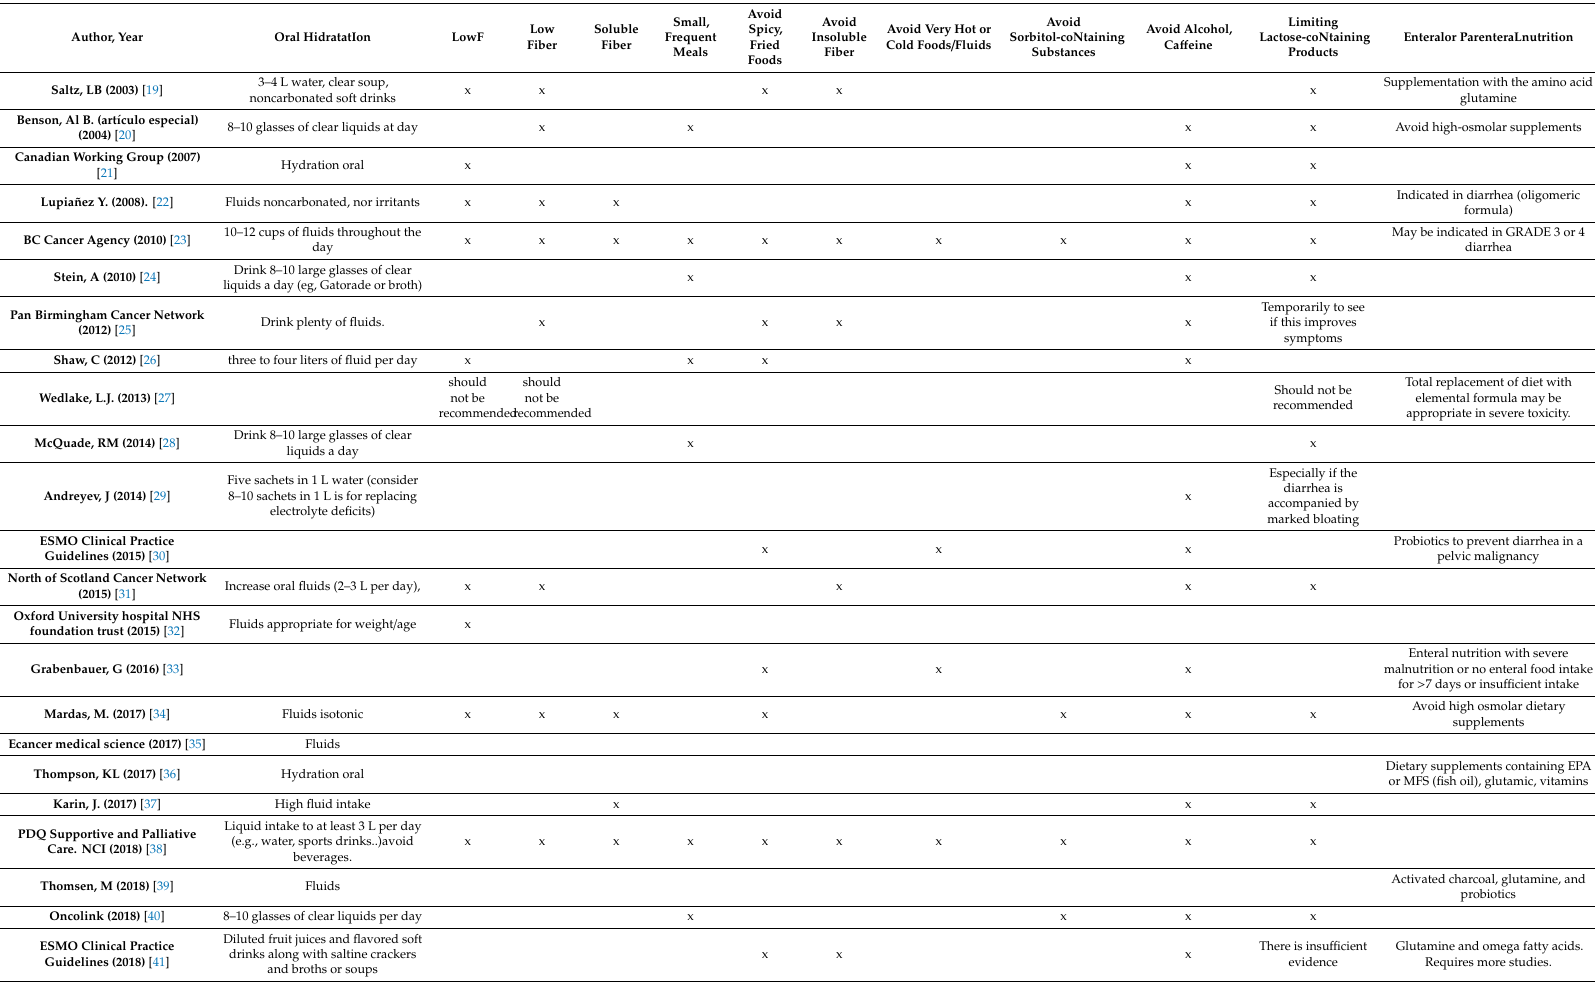
Table 1. Clinical Practice Guidelines for the management of oncology treatment-related diarrhea